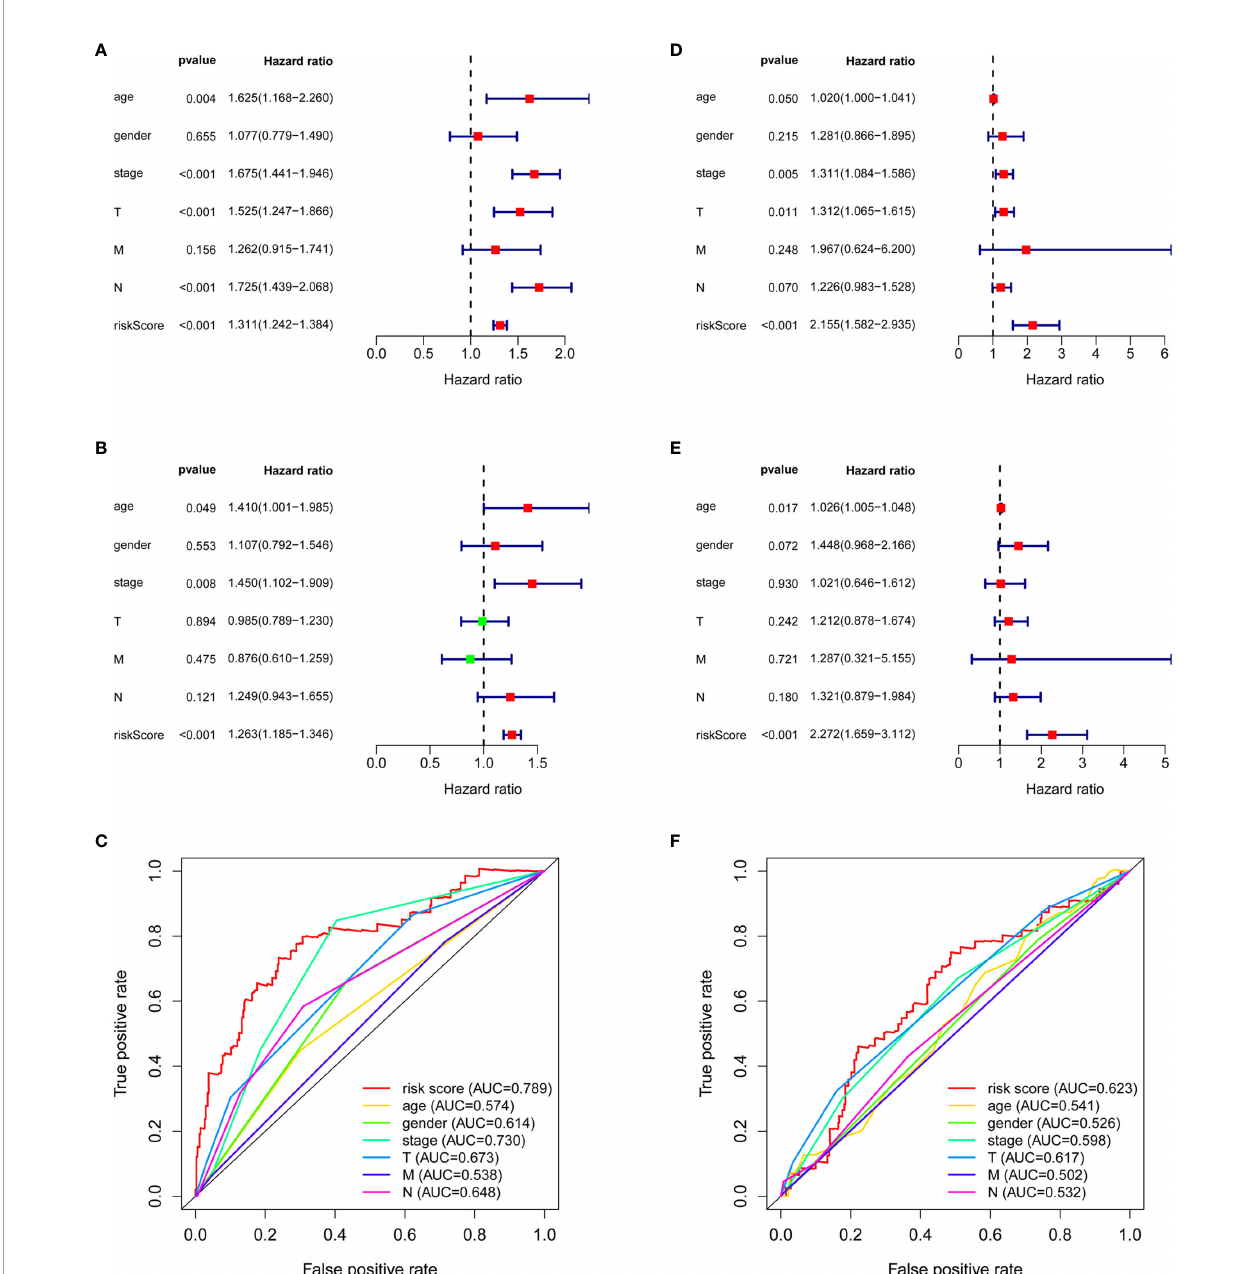
FIGURE 3 | The comparison between risk score and clinical factors. Univariate Cox analysis on clinical factors and risk score for AD patients (A) and SCC patients (D) . Multivariate Cox analysis on clinical factors and risk score for AD patients (B) and SCC patients (E) . ROC curves of clinical factors and risk score for AD patients (C) and SCC patients (F)